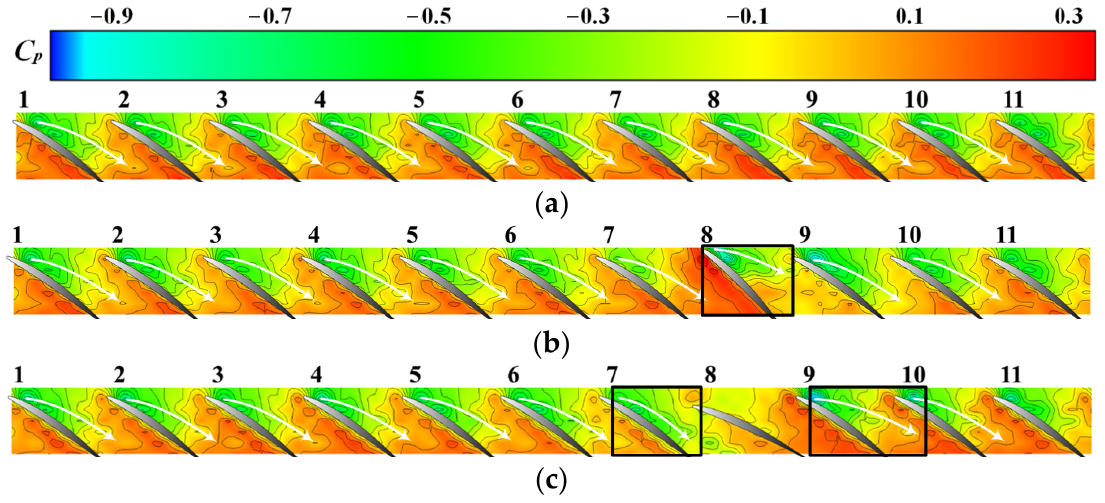
Figure 11. Blade-to-blade casing static pressure contour variability ( Φ = 0.580 ); ( a ) for Case 0, ( b ) for Case 1, and ( c ) for Case 2.